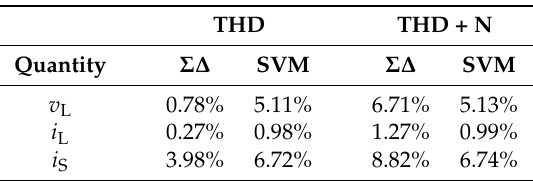
Table 3. Comparison of total harmonic distortion (THD) and total harmonic distortion plus noise (THD + N) for Σ∆ and